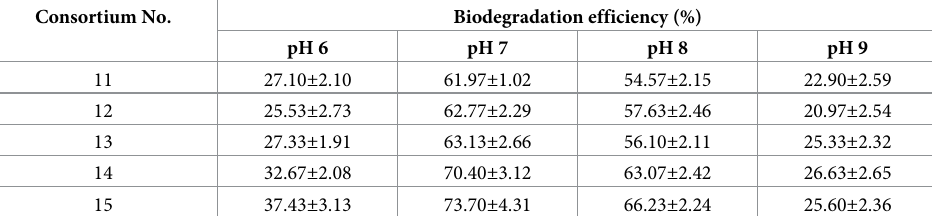
Table 11. Effect of initial pH on biodegradation efficiency of crude oil of 5 fungal consortia. Consortium No.